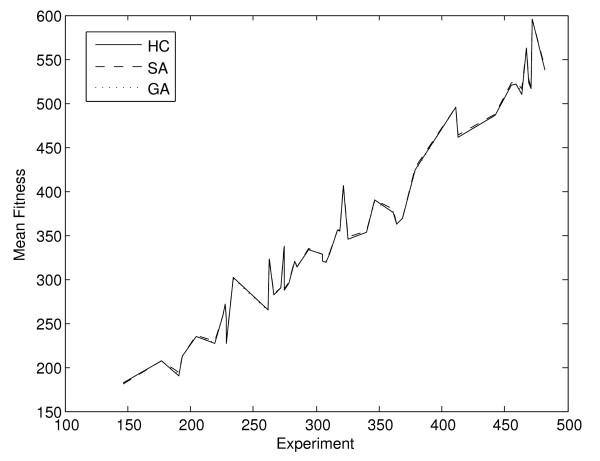
Mean fitness per experiment and method, according to search space. As the size of the search space grows, following the number of possible genes to pathways allocations, the methods are able to reach higher fitness values.